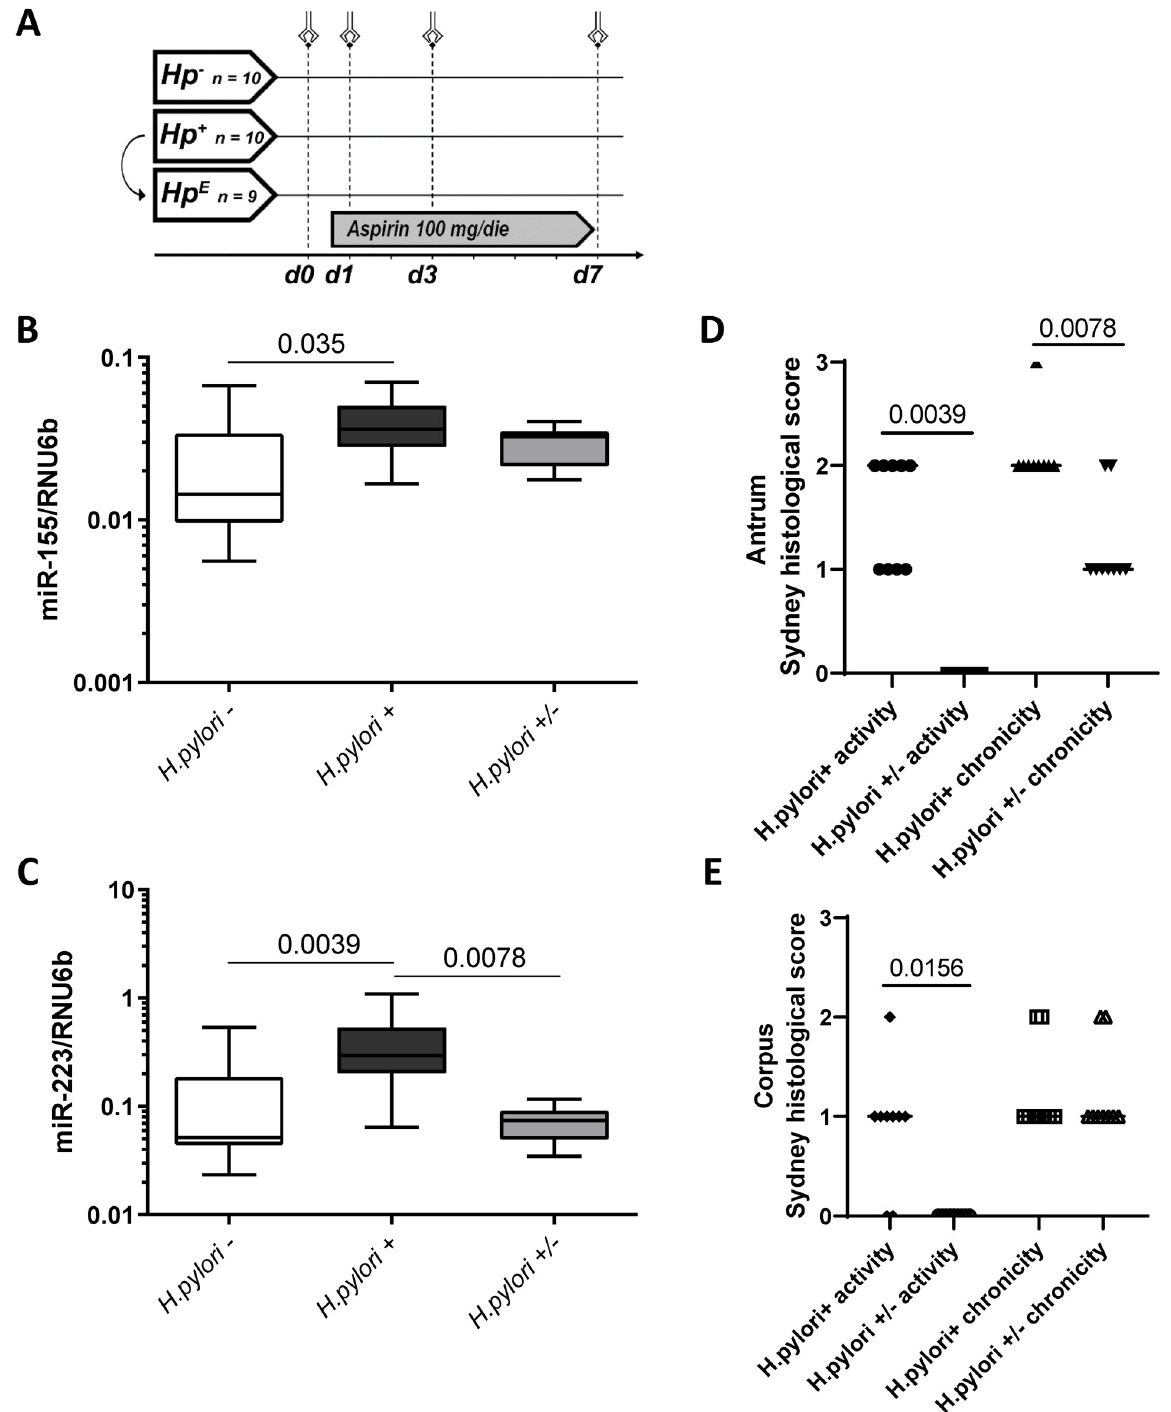
Fig 1. Expression of miR-155 and miR-223 in the context of H . pylori -gastritis. (A) Schematic representation of the LDA-study design (interventional study in healthy subjects); Hp - = H . pylori -negative group (n = 10); Hp + = H . pylori -positive group (n = 10); Hp E = H . pylori - eradicated group (n = 9); volunteers were challenged with a daily dose of LDA (100 mg/die) for 7 days (d1-d7). B-C : MiR-155 (B) and miR-223 (C) expression levels in gastric antral mucosa of H . pylori -negative healthy individuals ( H . pylori -; n = 10), H . pylori -infected subjects ( H . pylori +; n = 10) and in individuals after eradication treatment ( H . pylori +/-; n = 9). MiRNA expression levels are shown as 2 Δ CT-values normalized to RNU6b and data are shown as box-plots where the horizontal line marks the median value. D-E : Histological changes in inflammation following